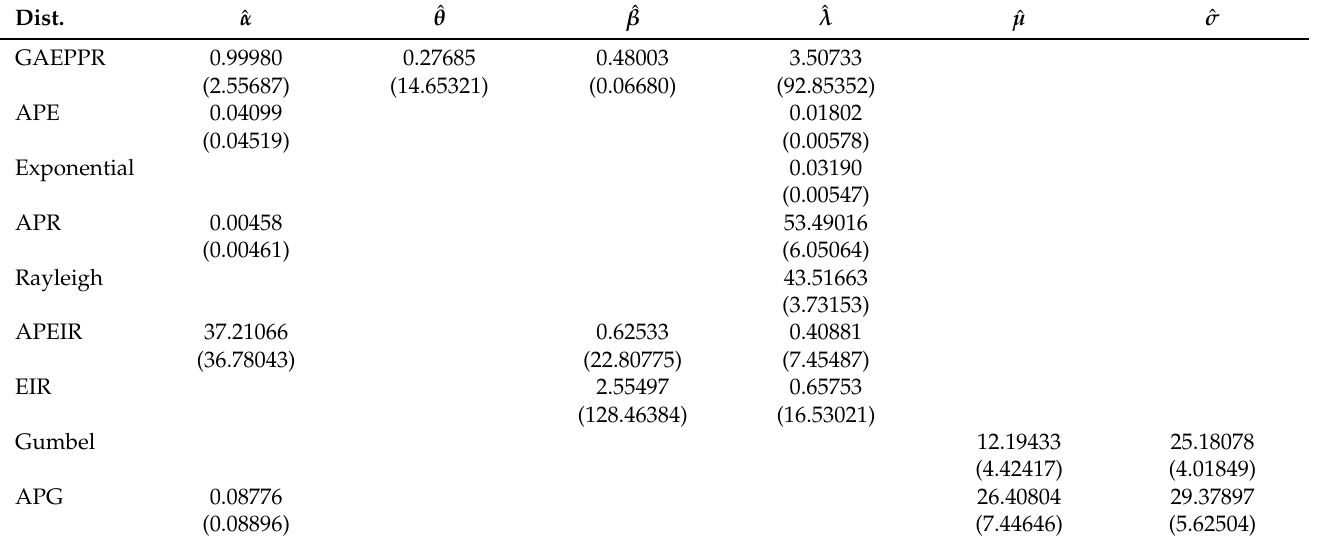
Table 3. MLEs with SE (in parentheses) of competing models for the runoff data.